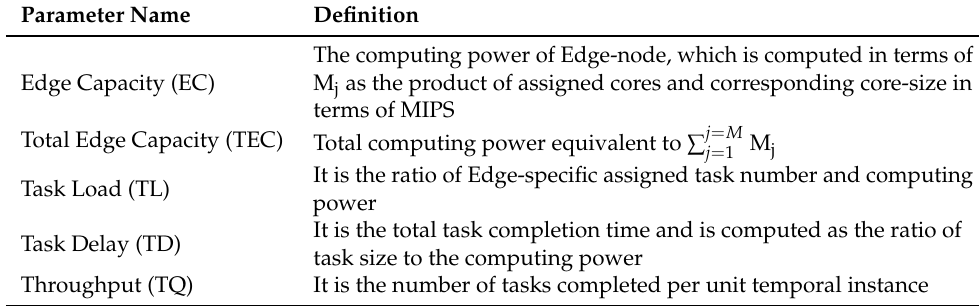
Table 3. Task Allocation